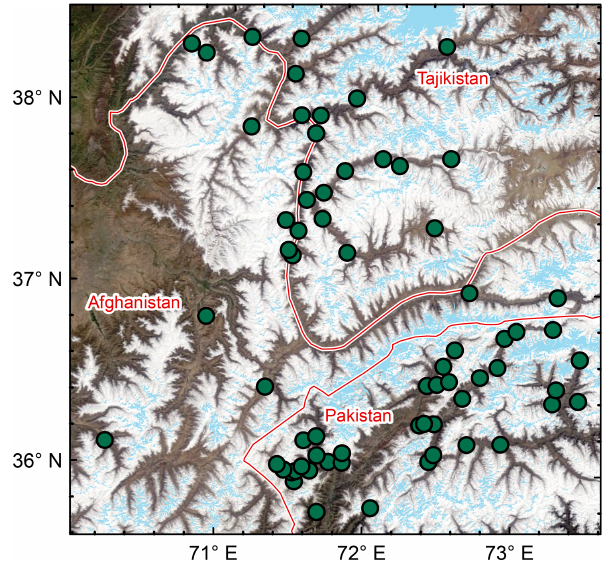
Figure 1. Study region with AKAH stations (green dots) overlaid on a MODIS true-color image from 13 April 2018. Also shown are the country boundaries (red) and glacierized areas (light blue) from the Global Land Ice Measurements from Space dataset (Raup et al., 2007). All of the stations in Afghanistan and Tajikistan are in areas that eventually flow into the Amu Darya. All of the stations in Pakistan are in areas that eventually flow into the Indus River. Imagery courtesy of NASA